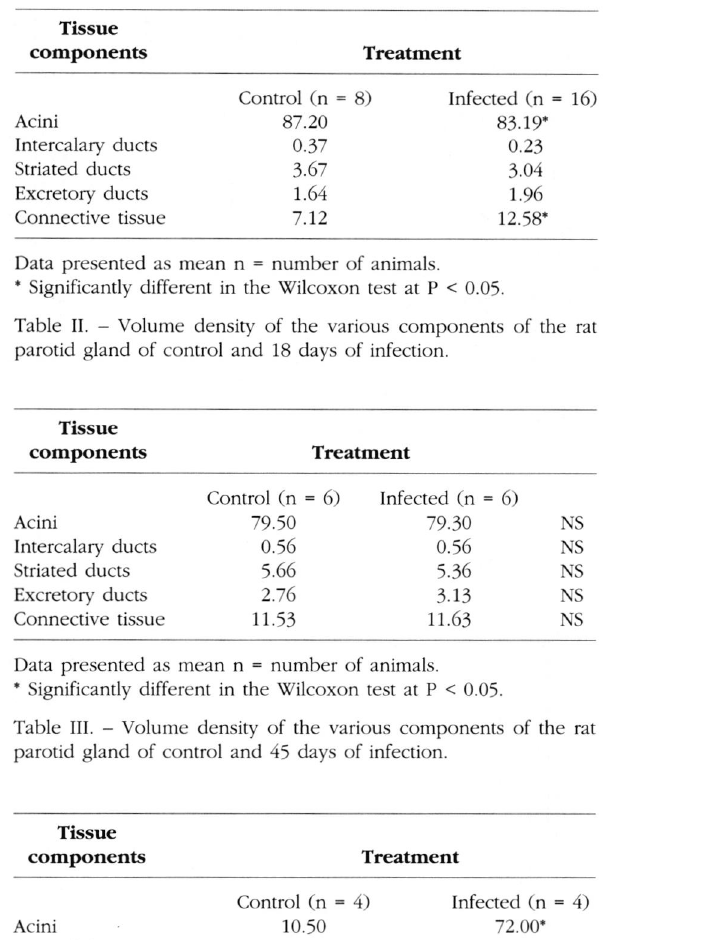
Table III. - Volume density of the various components of the rat parotid gland of control and 45 days of infection.